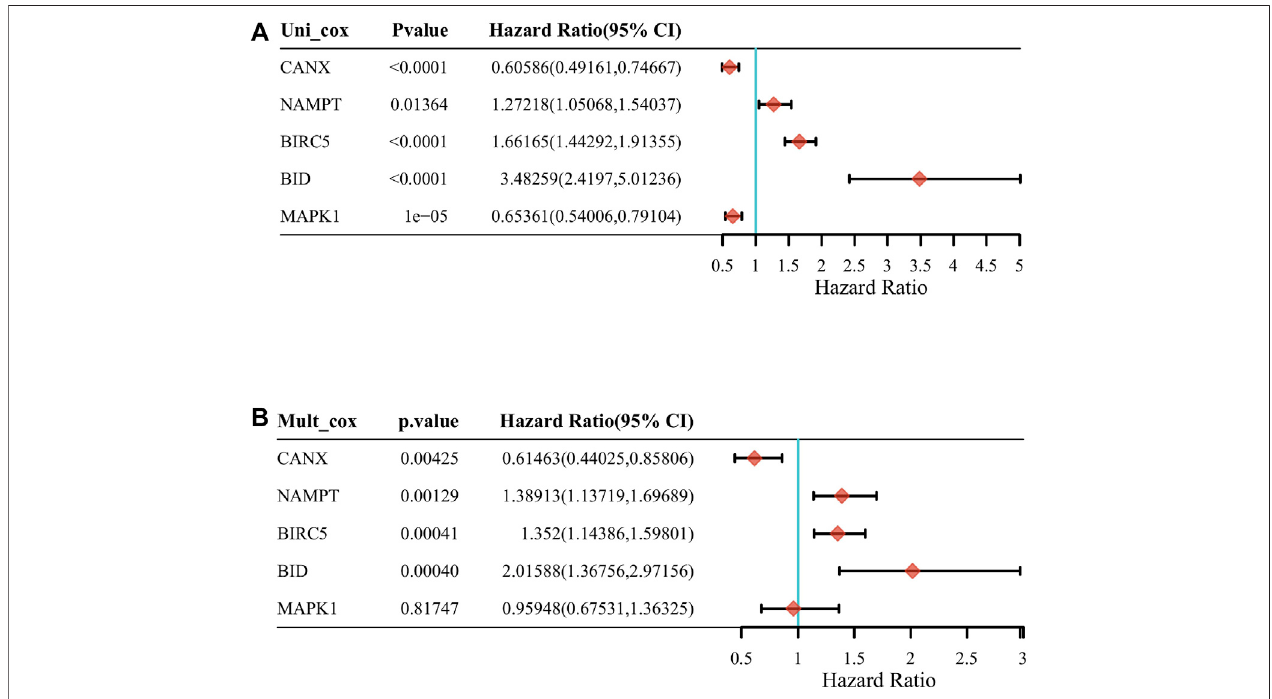
FIGURE3| Thecorrelationbetweenthe fi vedifferentiallyexpressedgenes(DEGs)andprognosis.TheforestplotshowstheresultsoftheunivariateCoxregression analyses of the fi ve immune-autophagy genes in The Cancer Genome Atlas – kidney renal clear cell carcinoma (TCGA-KIRC) (A) . The forest plot shows the results of the multivariate Cox regression analyses of the fi ve immune-autophagy genes in TCGA-KIRC (B) . And CANX, BIRC5, NAMPT, and BID were signi fi cant.